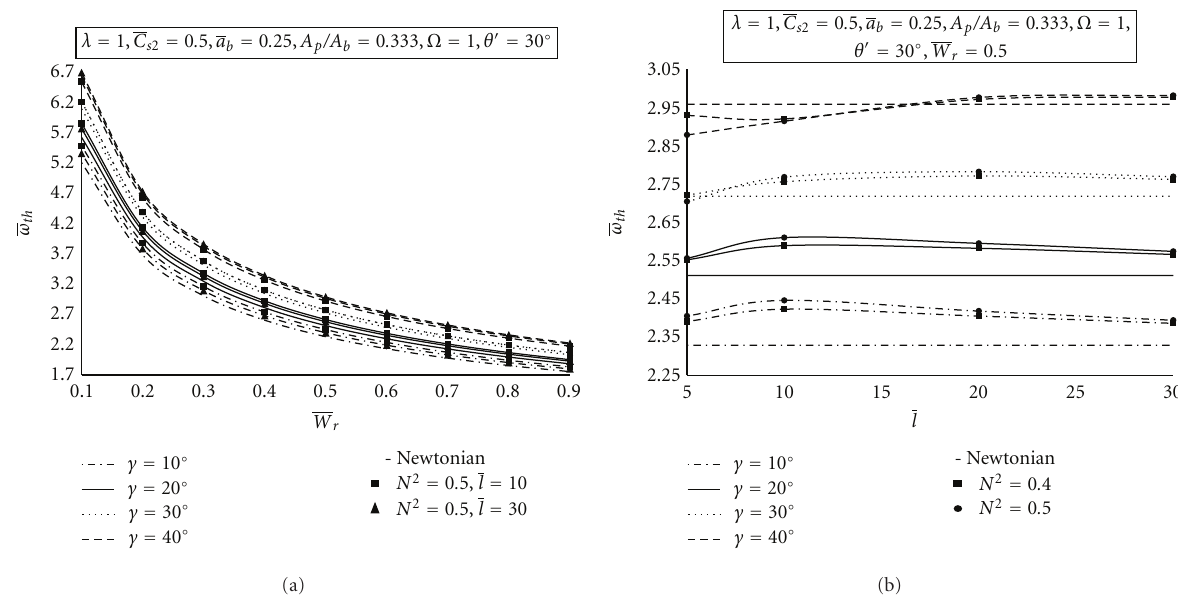
Figure 12: (a) Variation of ω th versus radial load W r . (b) Variation of ω th characteristic length l